Question: What visual encoding does this figure use to show its data?
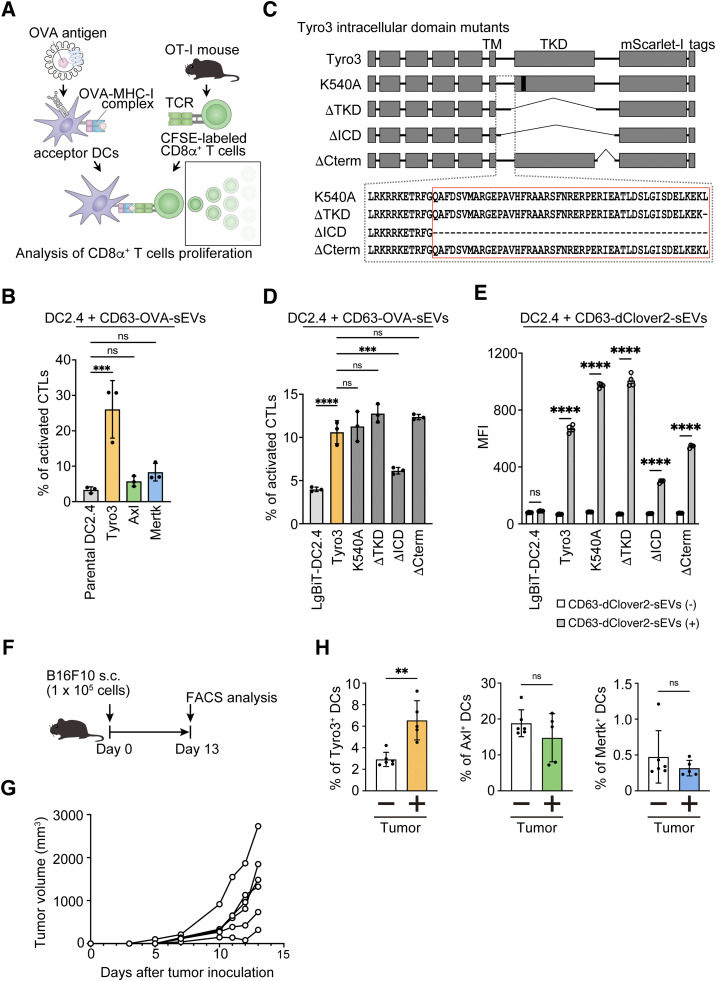
Answer: line